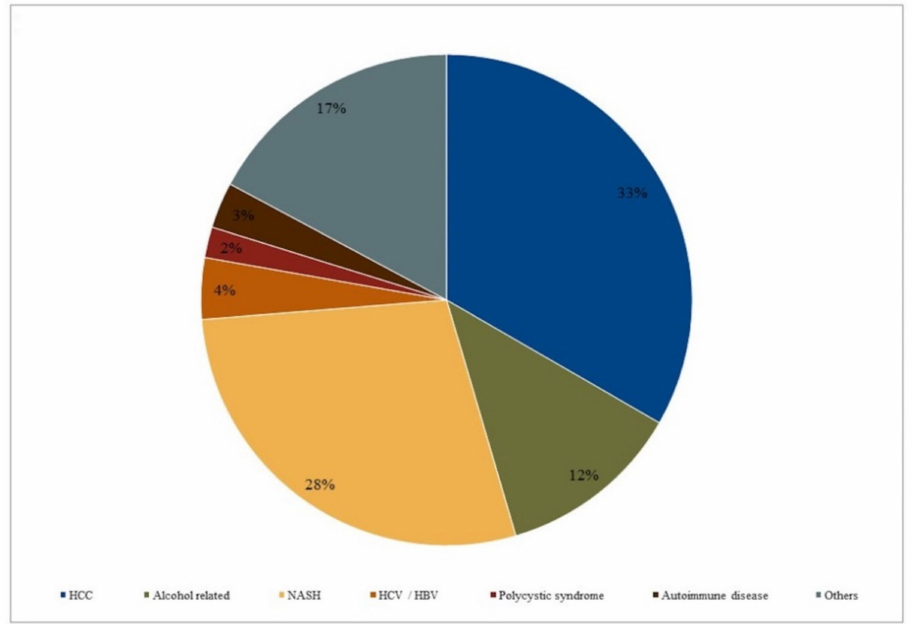
Figure 2. Main etiologies in the